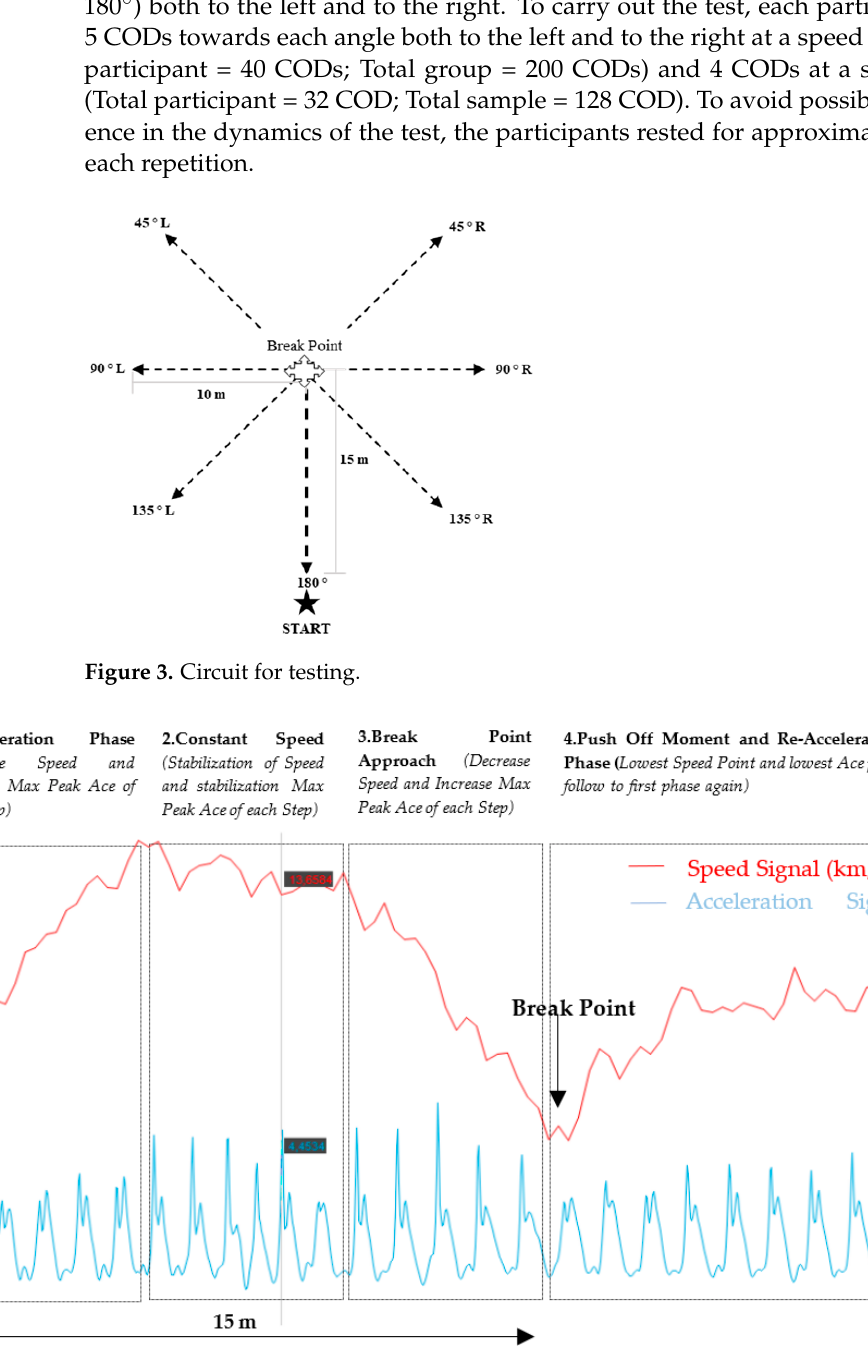
Figure 4. X-Axis Acceleration Channel (blue) and velocity (red) during the course of a COD at 45° at 13 km/h. Different biomechanical phases of a COD.